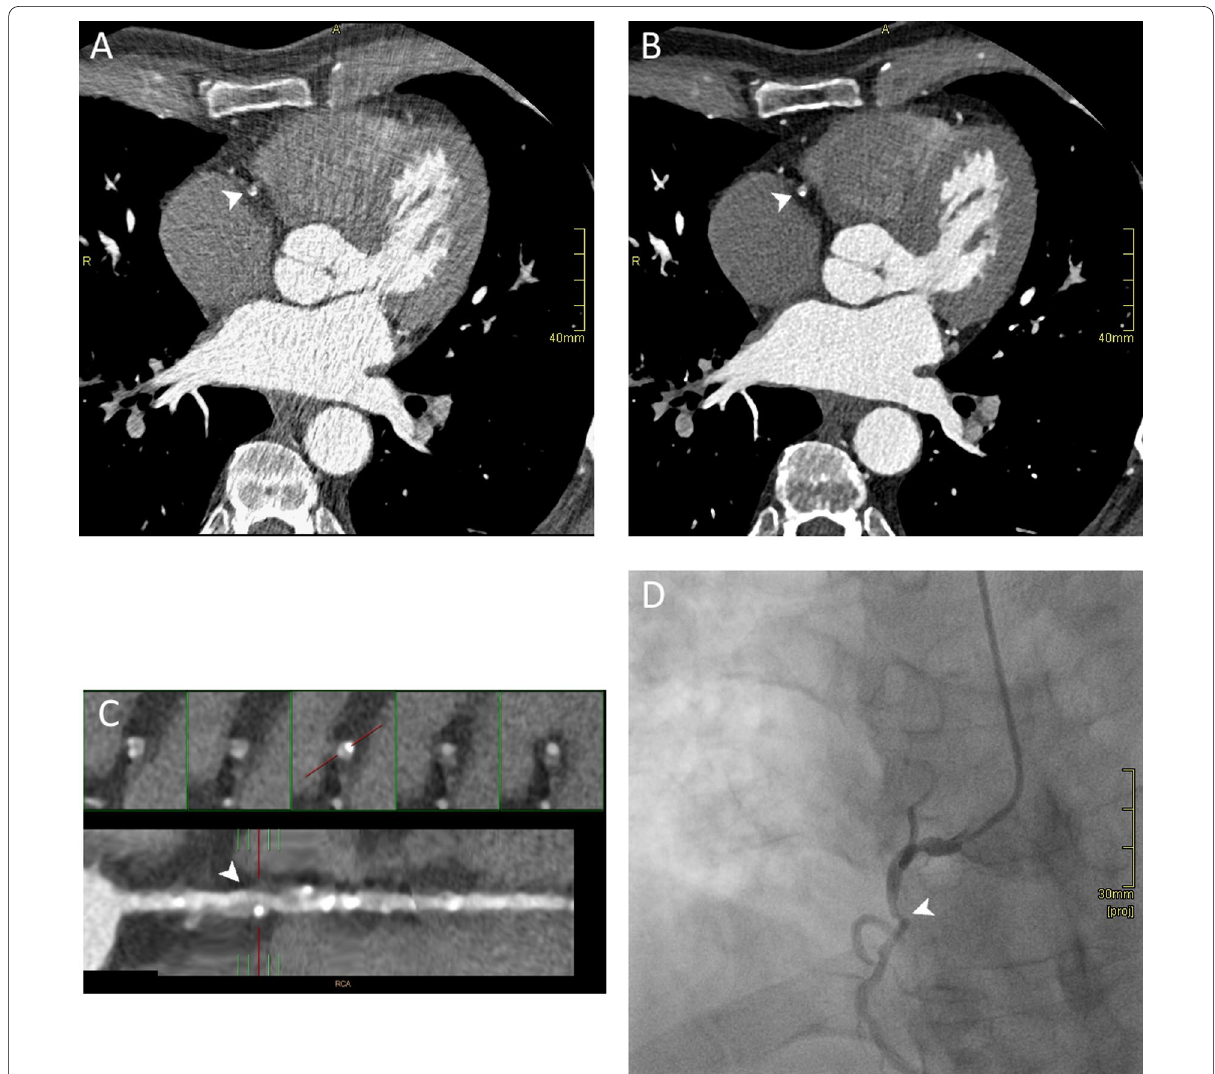
Fig. 5 Comparison of CT images reconstructed with IR and MBIR algorithm and invasive coronary angiography (ICA) in a 65-year-old male patient with thoracic pain after exercise and a history of smoke and arterial hypertension. CT was acquired with 80-kV ECG-gated protocol (HR: 62 bpm). a–b Axial image reconstructions at the same level of the right coronary artery (RCA) show the presence of fibrous and calcified atherosclerotic plaque. MBIR image presented a lower noise level and higher contrast-to-noise ratio, leading to a better evaluation of the pathological findings. c Straight reconstruction which better shows the presence of multiple atherosclerotic plaques along the whole vessel. At the proximal tract, there is severe stenosis (arrowhead) quantified as 85% and reported as CADARDS 4A. d Invasive coronary angiography showing the stenosis reported in CT examination (arrowhead), confirmed as